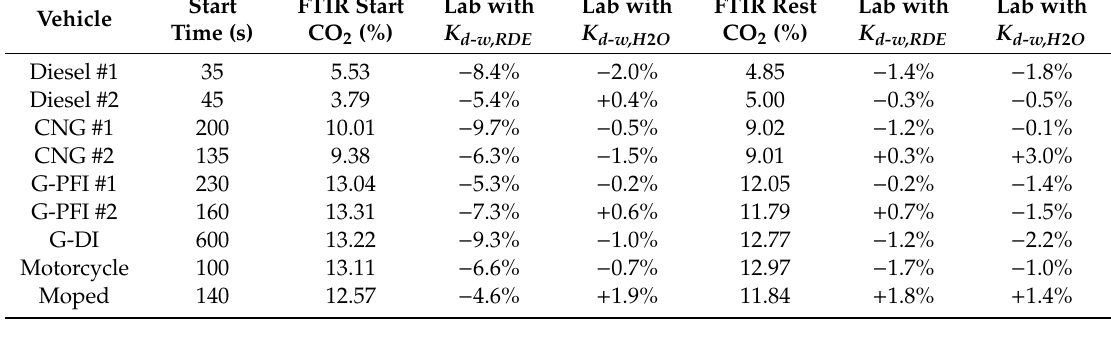
Table 4. Mean CO 2 concentration measurements (%) measured with the FTIR for the starting condensation period of the cycle and the rest of the cycle. The laboratory to the FTIR differences are given using the two conversion factors (real driving emissions (RDE) or H 2 O). Vehicles and acronyms as in Table 1.